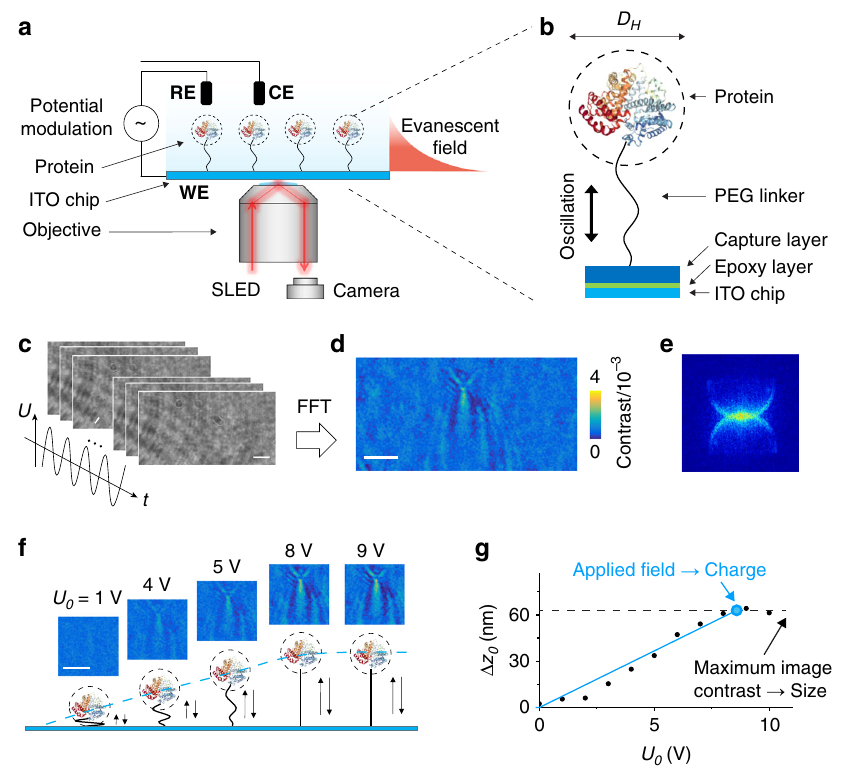
Fig. 1 Imaging single proteins and mechanical oscillations. a Proteins are tethered to an ITO surface with a fl exible polymer tether, and driven into oscillation by an alternating electric potential applied to the surface with a three-electrode electrochemical con fi guration, where WE, RE, and CE are the working (the ITO surface), reference (Ag/AgCl wire) and counter electrodes (Pt coil), respectively. The oscillating protein molecules scatter the evanescent fi eld generated by illuminating the ITO surface with light from a SLED, and the scattered light is collected to form an image captured with a CMOS camera. b The polymer tether is a 63 nm long polyethylene glycol (PEG), which links the protein (hydrodynamic diameter, D H ) to the ITO surface via surface chemistry described in “ Methods ” . c Time sequence images of oscillating molecules (bovine serum albumin or BSA) recorded at 800 frames/s with potential modulation amplitude and frequency of 8 V and 80 Hz, respectively. d Fast Fourier Transform (FFT) fi lter is applied to the time sequence images shown in c to produce an FFT image, which resolves a single BSA molecule. e Spatial Fourier transform of the FFT image (k-space) in d showing two rings, indicating the FFT image pattern is due to the interference between a planar wave (evanescent) and circular (scattering by a molecule) waves. f FFT image contrast vs. potential amplitude, showing a linear regime at low electric fi elds, and a plateau regime associated with fully stretching of the PEG tether at high electric fi elds. The two regimes are indicated by the blue dash line. g Oscillation amplitude ( Δ z 0 ) of a BSA molecule vs. potential amplitude ( U 0 ). Diameter and charge are determined from the amplitude of the plateau regime (black dash line) and the slope of the linear regime (blue line), respectively. Scale bars in c , d , f represent 3 µ